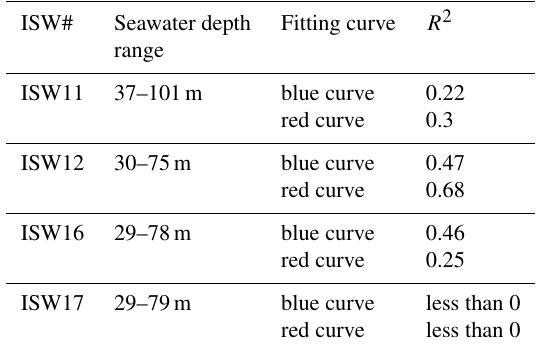
Table 7. Fitting effects of each curve in Fig. 12 on the observation